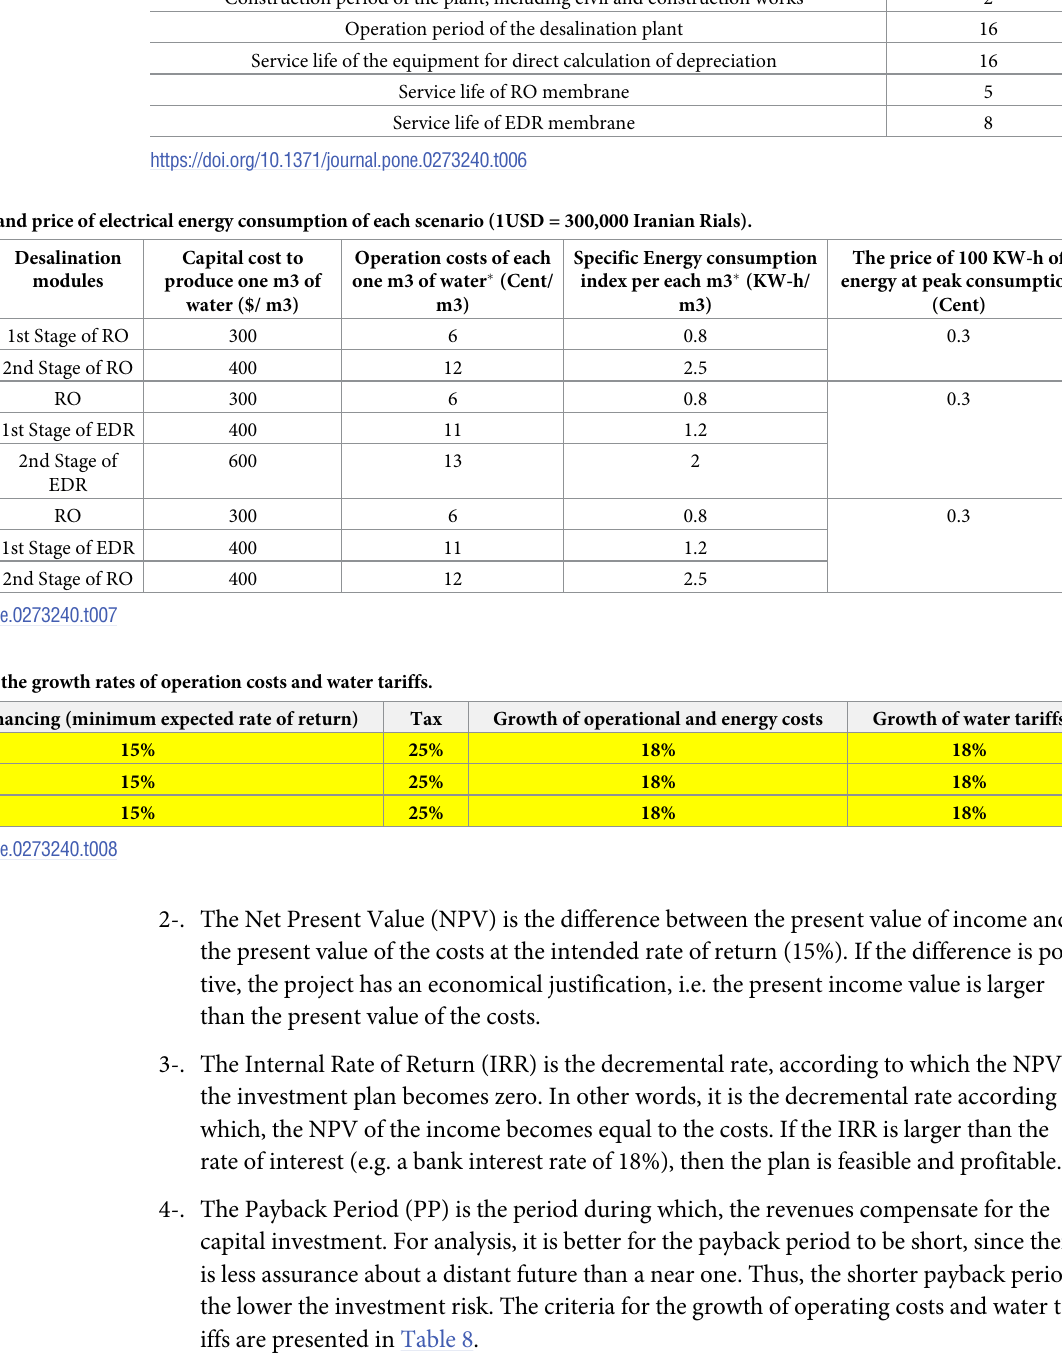
Table 6. The criteria of financial model for phase 2 of the Eshtehard hybrid brackish water desalination plan.